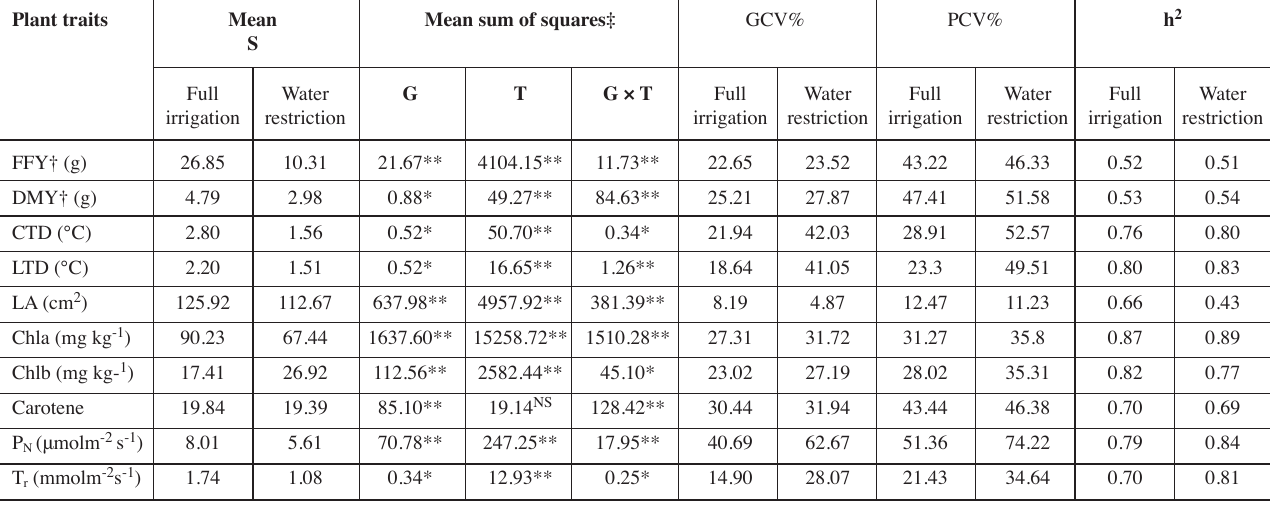
Tab. 3: Mean, analysis of variance, genotypic coefficient of variation (GCV%), phenotypic coefficient of variation (PCV%) and heritability (h 2 ) for fresh forage yield (FFY), dry forage yield (DFY), canopy temperature depression (CTD), leaf temperature depression (LTD), net photosynthesis rate (P N ) and transpiration rate (T r ) of berseemclover under full irrigation and water restriction conditions.